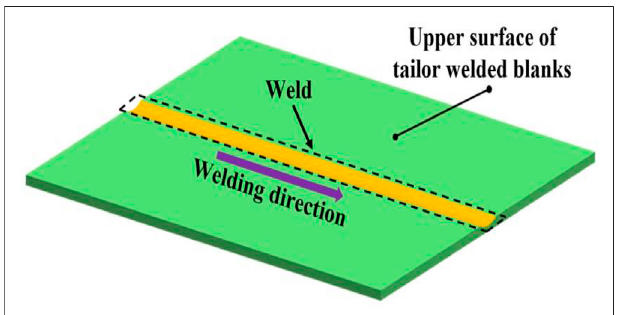
FIGURE 1 | 2195 Al-Li alloy tailor welded blank produced by FSW.